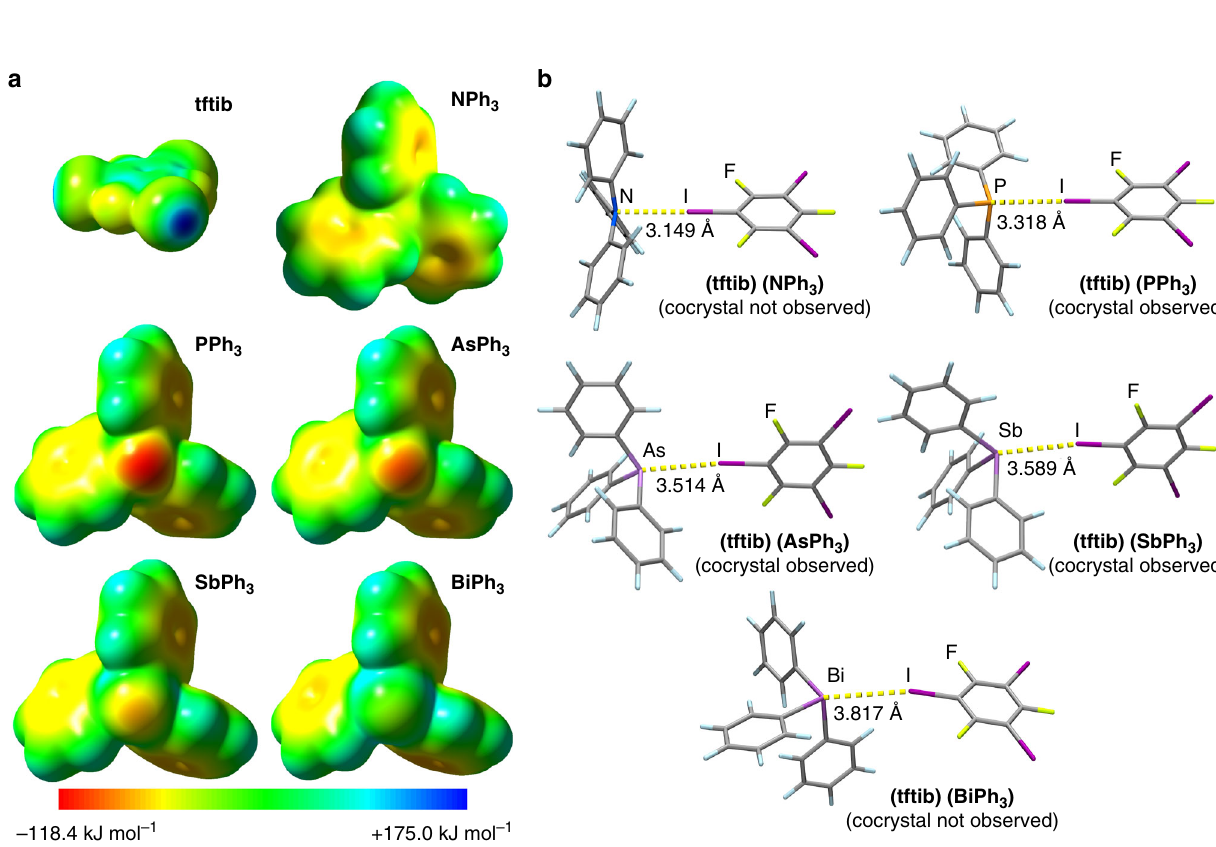
Fig. 4 Theoretical analysis of halogen-bonded complexes. a Comparison of calculated ESPs for the donor and all acceptors with isosurfaces plotted at 0.002 a.u. b Optimized gas-phase geometries for the halogen-bonded complexes ( tftib )( NPh 3 ), ( tftib )( PPh 3 ), ( tftib )( AsPh 3 ), ( tftib )( SbPh 3 ), and ( tftib ) ( BiPh 3 ). Supplementary Data 10 – 14 contain geometries for all optimized gas-phase dimers in XYZ format (see Supplementary Note